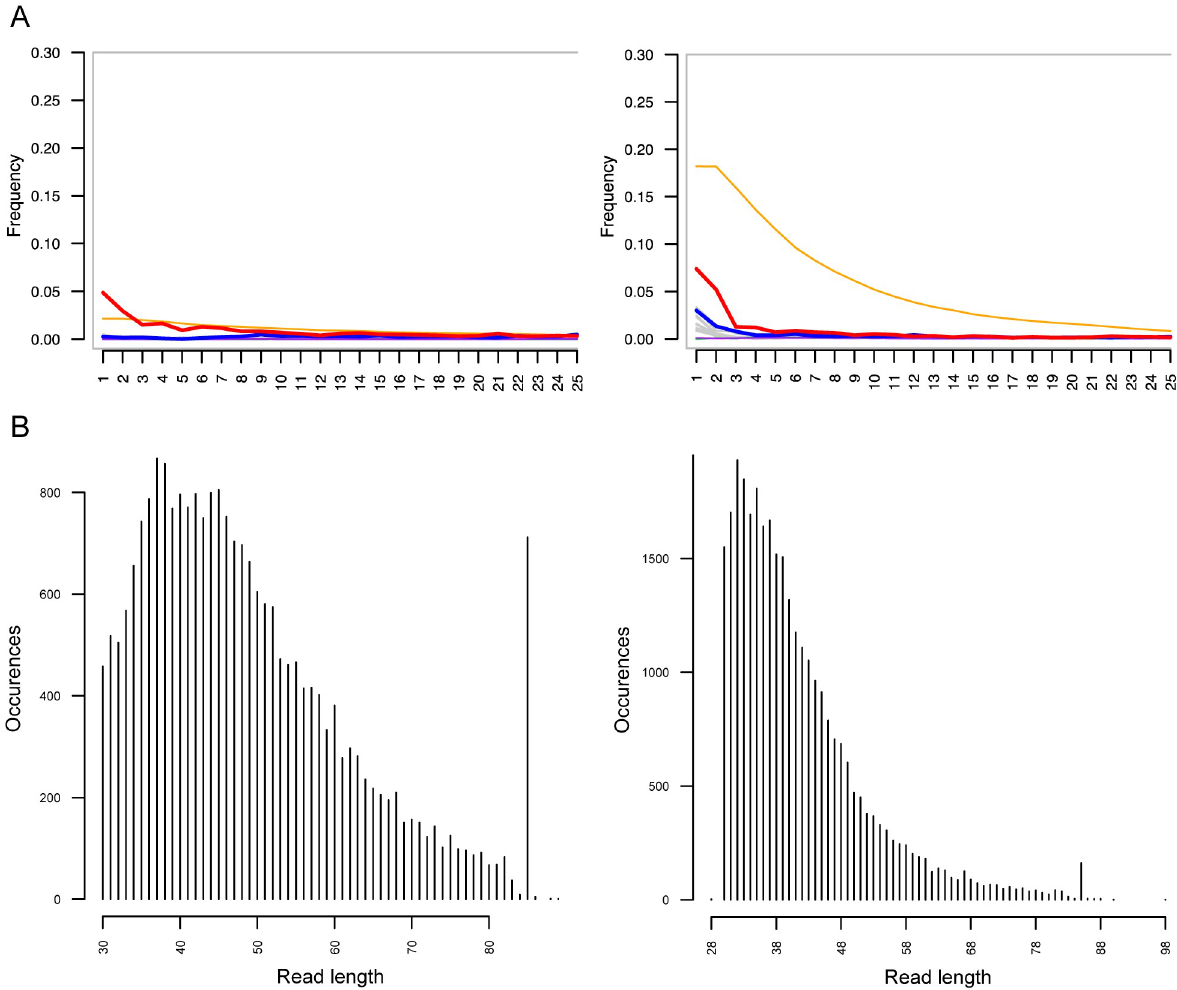
Fig 4. Ancient DNA authentication. Older mummy (OM S1, tooth root) on the left, younger mummy (YM S5, hair) on the right. A. DNA damage at the ends of fragments. Red line—C= > T substitutions; blue line—G= > A substitutions; orange line—soft-clipped bases. B. Read length distribution of sequencing reads mapped to the human reference